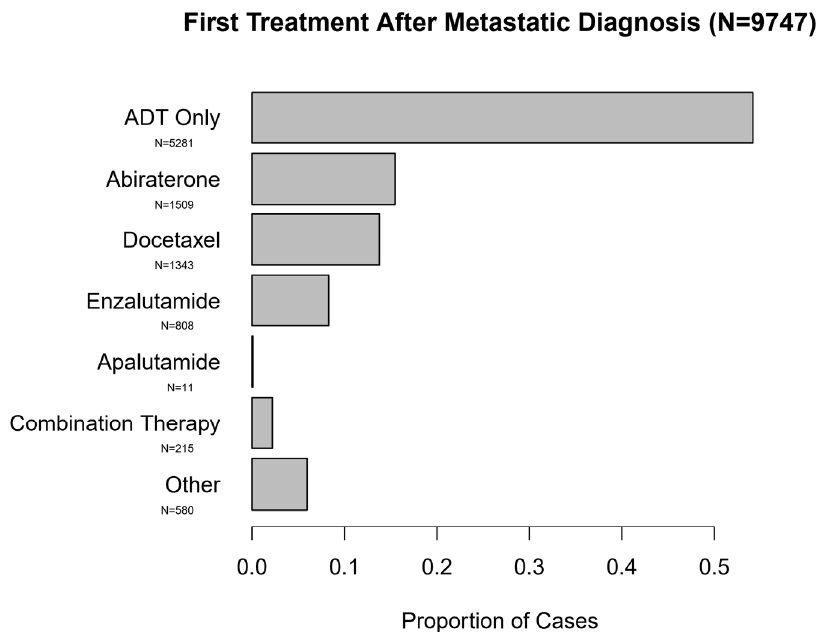
Figure 2. First Treatment After Metastatic Diagnosis ( N = 9747).